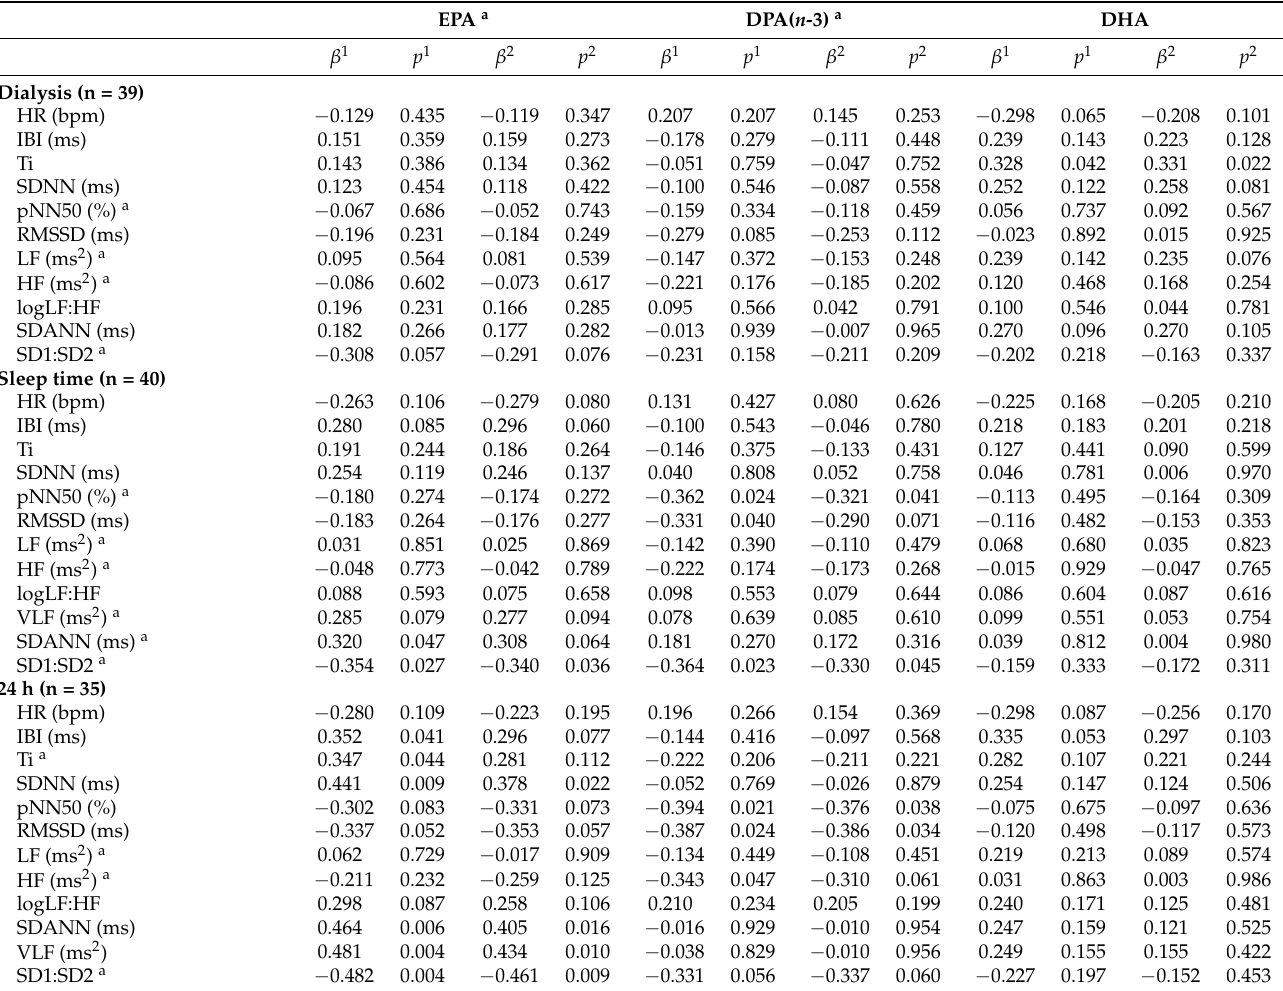
Table 4. Simple and multivariable linear regression analyses between plasma LC n -3 PUFA and HRV during dialysis (2 h), sleep time and over a 24 h